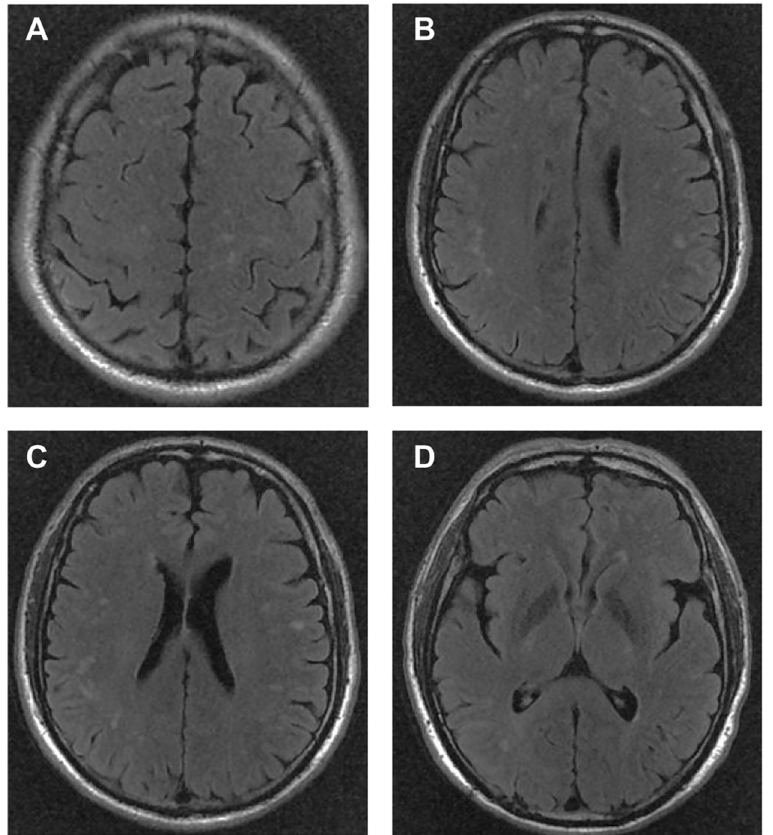
Figure 1. Radiologic features of MOG-IgG-positive patients with cranial neuropathies. T2-FLAIR hyperintensities in the subcortical white matter of bilateral frontal lobe ( A ); bilateral frontal and parietal lobe ( B , C ); and right occipital lobe near the posterior horn of the lateral ventricle ( D ).